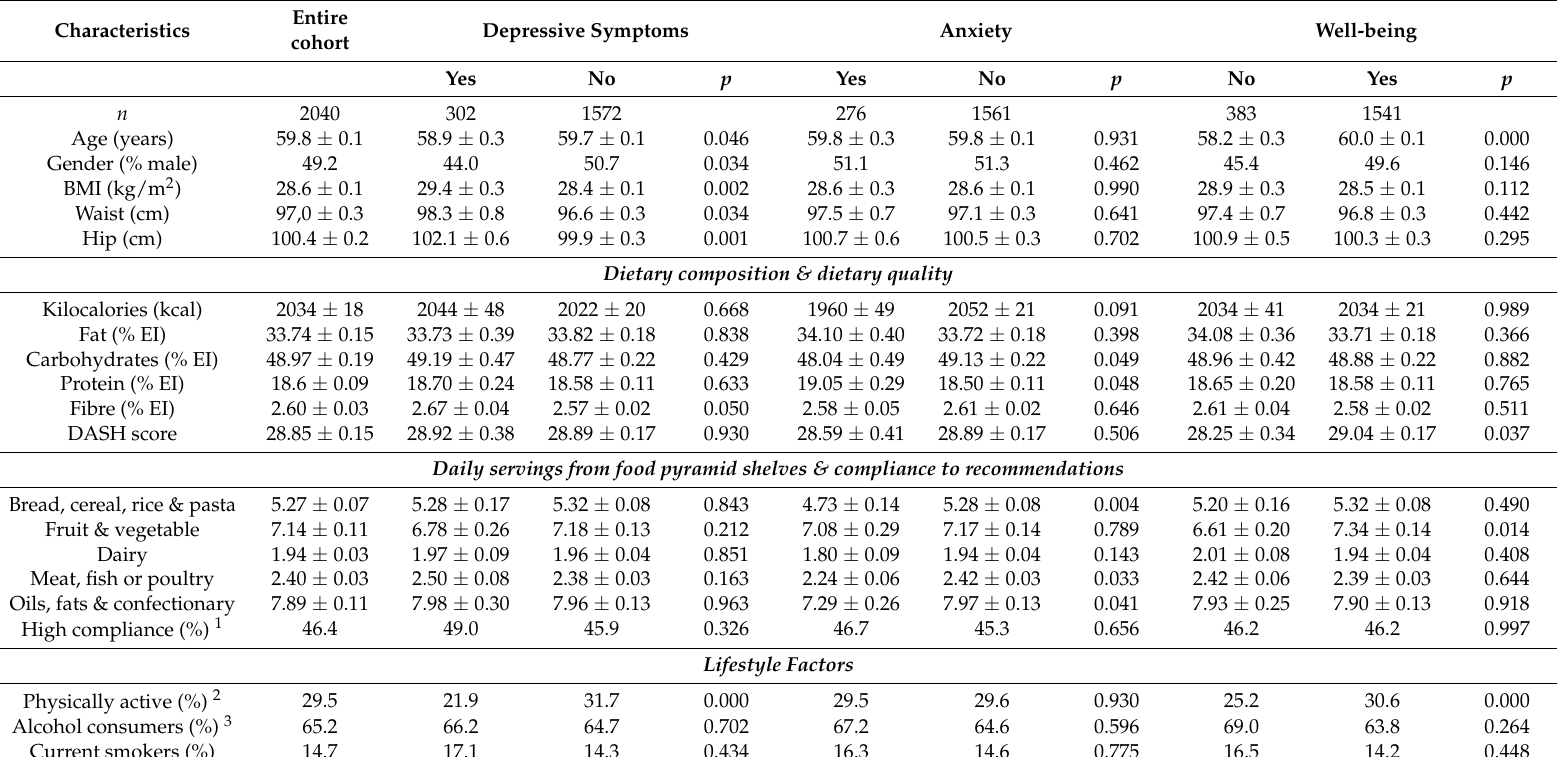
Table 1. Demographic, dietary and lifestyle characteristics of the Mitchelstown cohort according to depressive symptoms, anxiety and well-being status. Entire Characteristics Depressive cohort